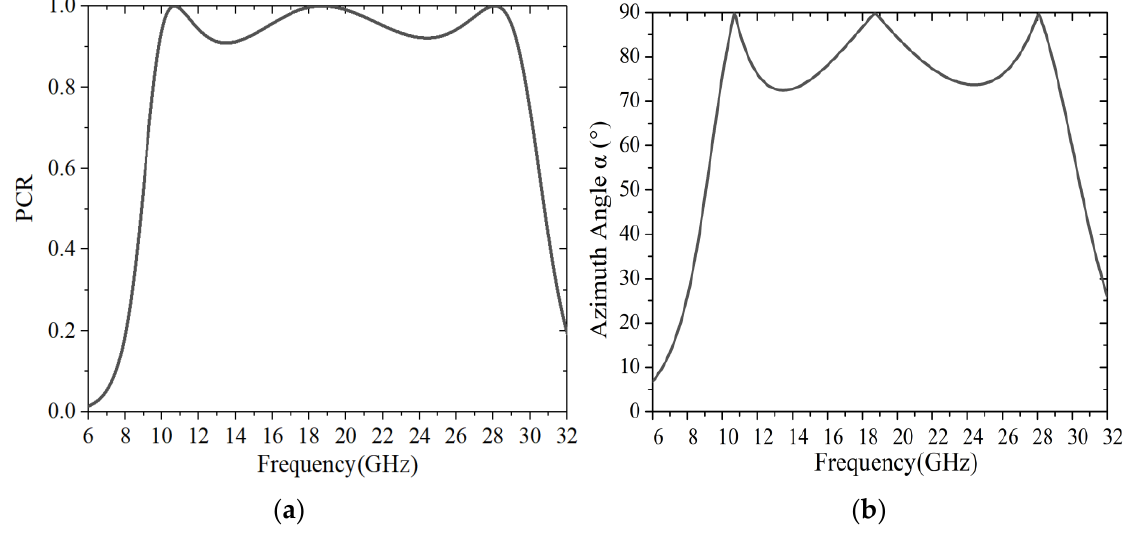
Figure 3. The simulated results for ( a ) PCR; ( b ) polarization azimuth angle α . )/arctan( rrα = xxyx